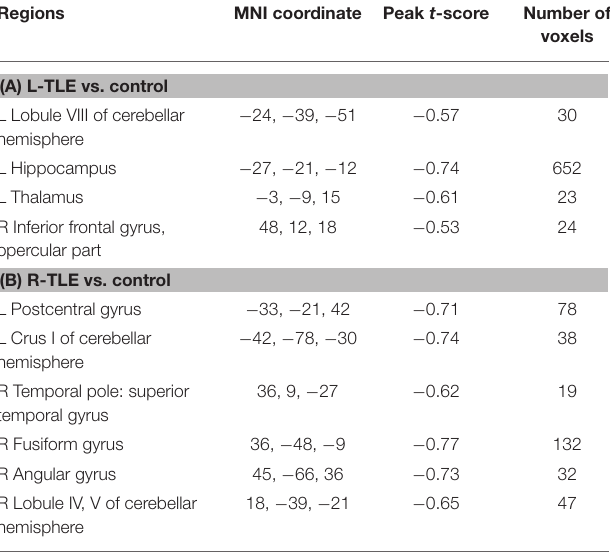
TABLE 4 | Group comparison of whole brain gray matter density (GMD) between the TLEs and the controls. Regions